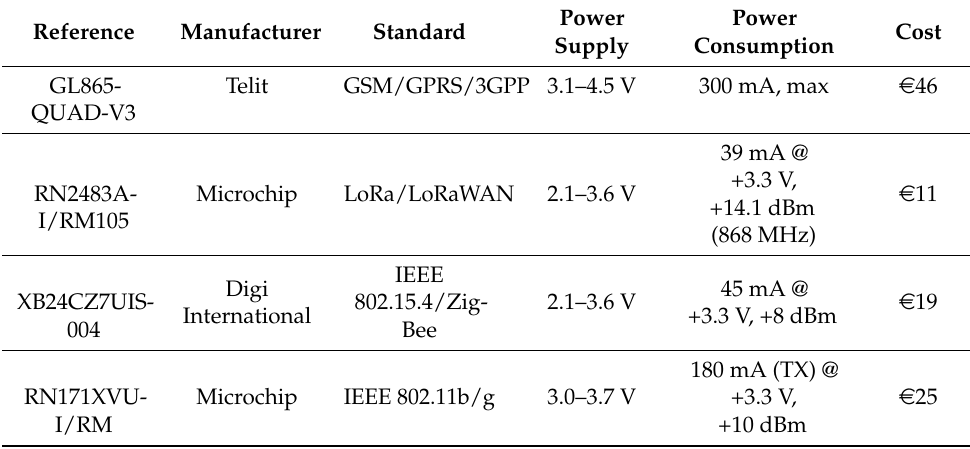
Table 3. Communications solutions available for use on the SPWAS’21